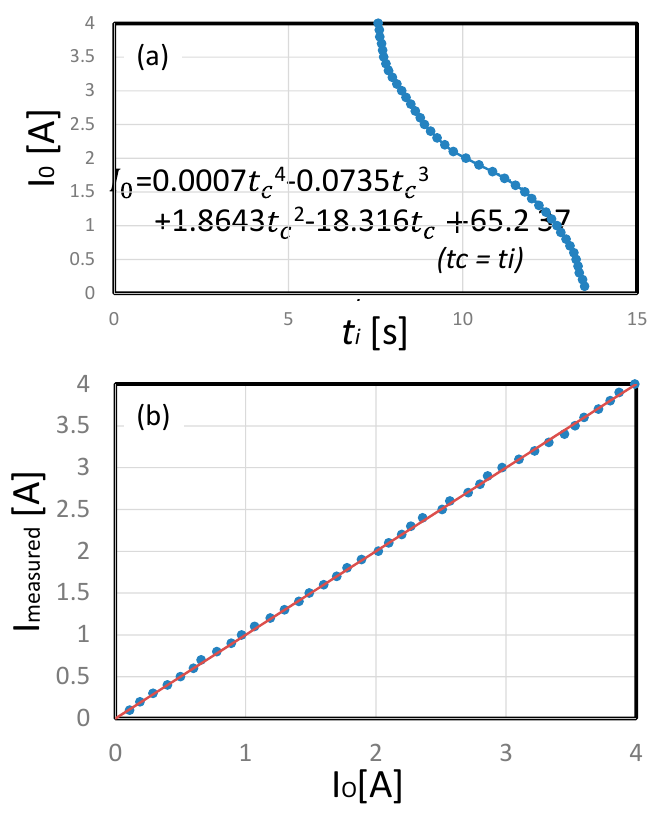
Figure 6. ( a ) Calibration formula for the DCC Beat Sensors; ( b ) Measured Io by the DCC beat sensors after